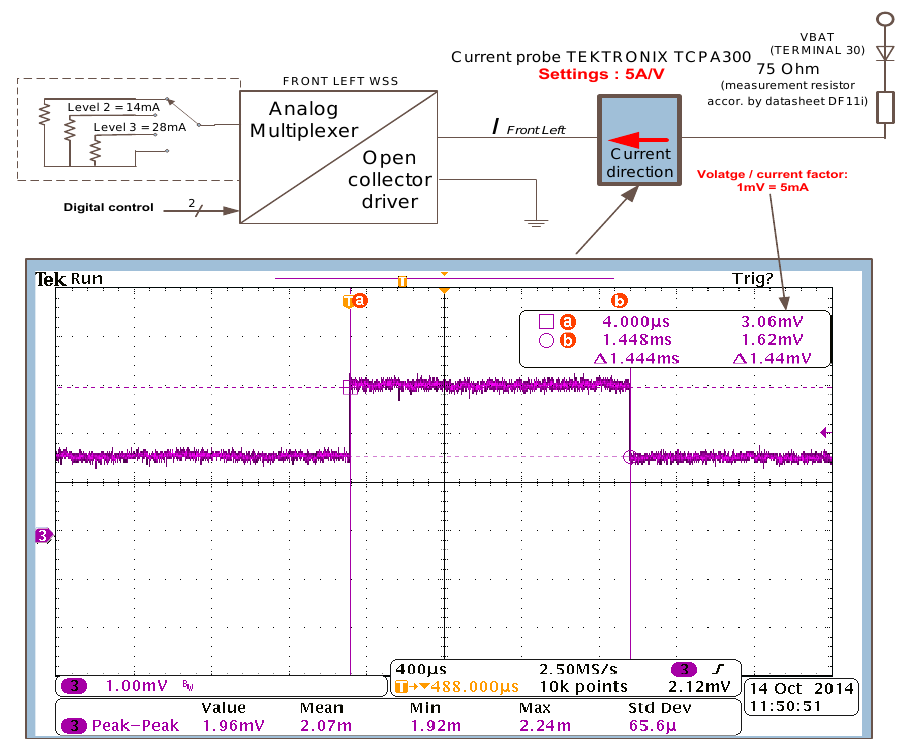
Figure 6 Emulation of the WSS DF11i - standstill idle current pulse (zero velocity)